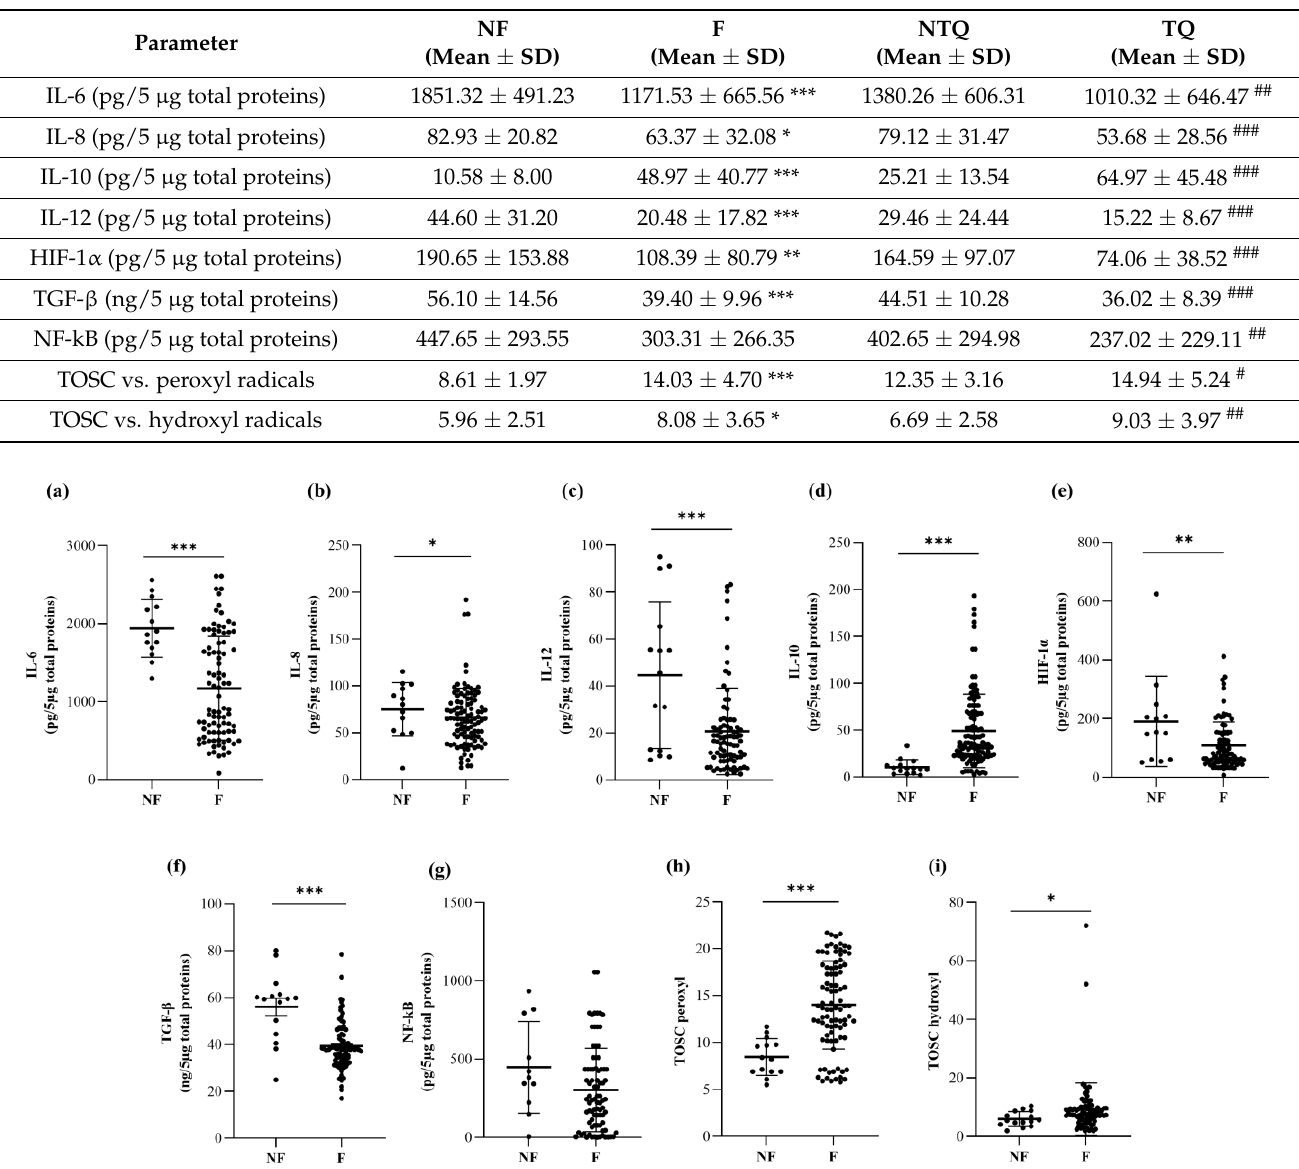
Table 2. Biochemical parameters measured in the follicular fluid (FF) collected from unfertilized (NF) and fertilized (F) oocytes, distinguished as poor-quality (NTQ) or top-quality (TQ) embryos. IL-6, IL-8, IL-10, and IL-12 are expressed as pg/5 µ g of total proteins in the FF. HIF-1 α and NF-kB are expressed as pg/5 µ g total proteins in the FF, while TGF- β is expressed as ng/5 µ g of total proteins in FF. TOSC values versus hydroxyl or peroxyl radicals are expressed as TOSC units. All the data are expressed as means ± SD. Statistical analysis was performed by unpaired t -tests between NF and F, and between TQ and NTQ. * p < 0.05, ** p < 0.01, *** p < 0.001 vs. NF; # p < 0.05, ## p < 0.01, ### p < 0.001 vs. NTQ.